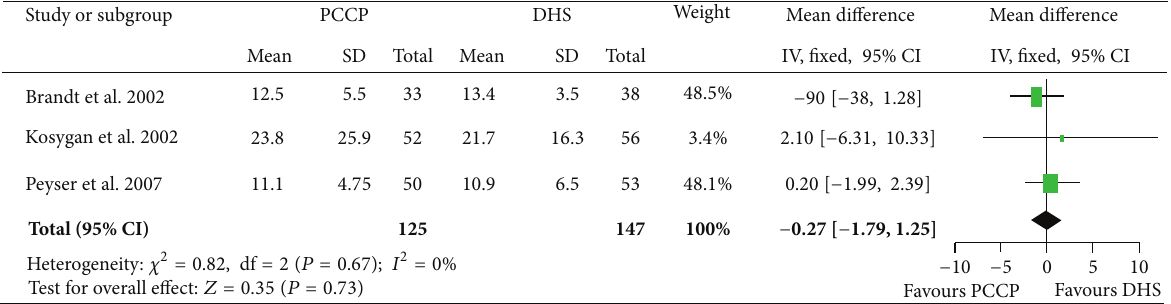
Figure 6: Comparison of length of hospitalization between PCCP and DHS.